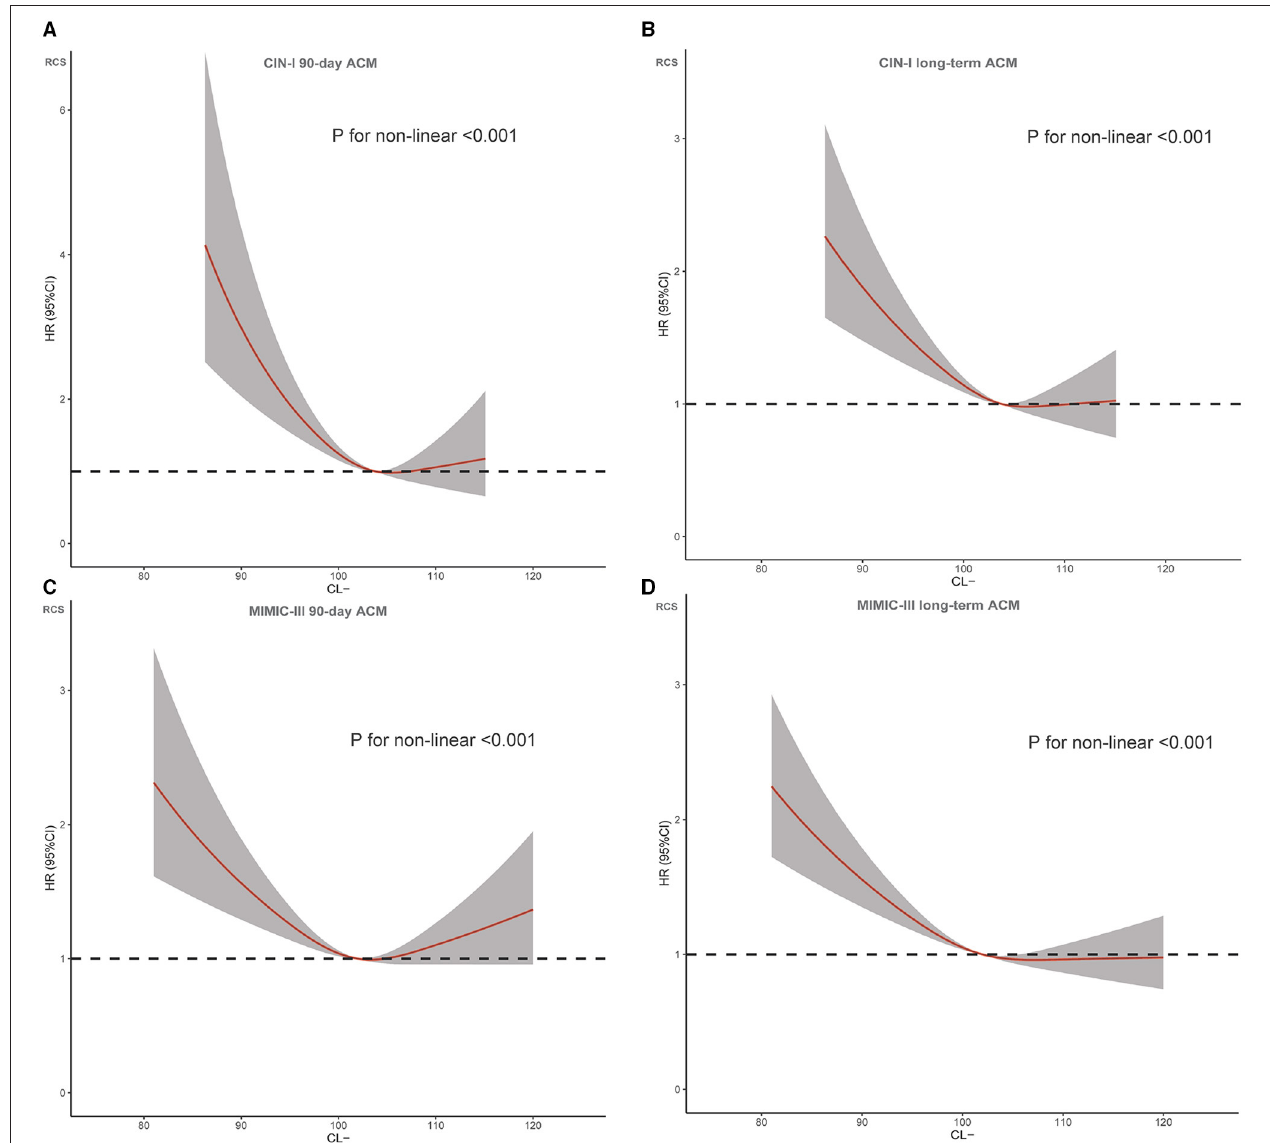
FIGURE 2 | Restricted spline curve for the chloridion hazard ratio ( HR ). (A) CIN-I 90-day ACM; (B) CIN-I long-term ACM (C) MIMIC-III 90-day ACM; (D) MIMIC-III long-term ACM.